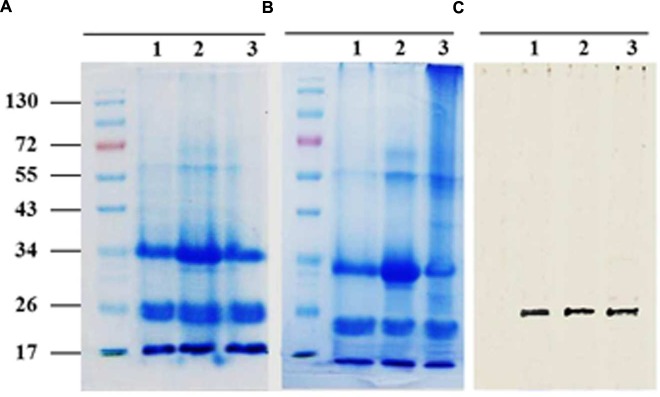
Sodium dodecyl sulfate polyacrylamide gel electrophoresis (SDS-PAGE) analysis for LD-associated proteins of date palm. Proteins were isolated from native or proteinase K-treated LDs as described in Section “Materials and Methods.” Resulted proteins from both samples of LDs were firstly quantified using protein assay from BioRad. (A) Three duplicate samples of 20 mg of native proteins and (B) Proteolytically treated proteins. Proteins were analyzed on 12% SDS-PAGE gels stained with G250 Coomassie blue. (C) Western immunoblot of caleosins detected by a polyclonal antibody prepared from the complete sequence of Clo1 caleosin from Arabidopsis thaliana, diluted 1:500 in TBS buffer (pH 7.4). A horseradish peroxidase-conjugated anti mouse IgG (Sigma-Aldrich, USA), diluted 1:2000, served as the secondary antibody. The signal was detected in a Pharos FX molecular imager (Bio-Rad; C, lanes 1–3). Five mL of a broad range protein marker was loaded to give bands at the indicated molecular weight in kDa.